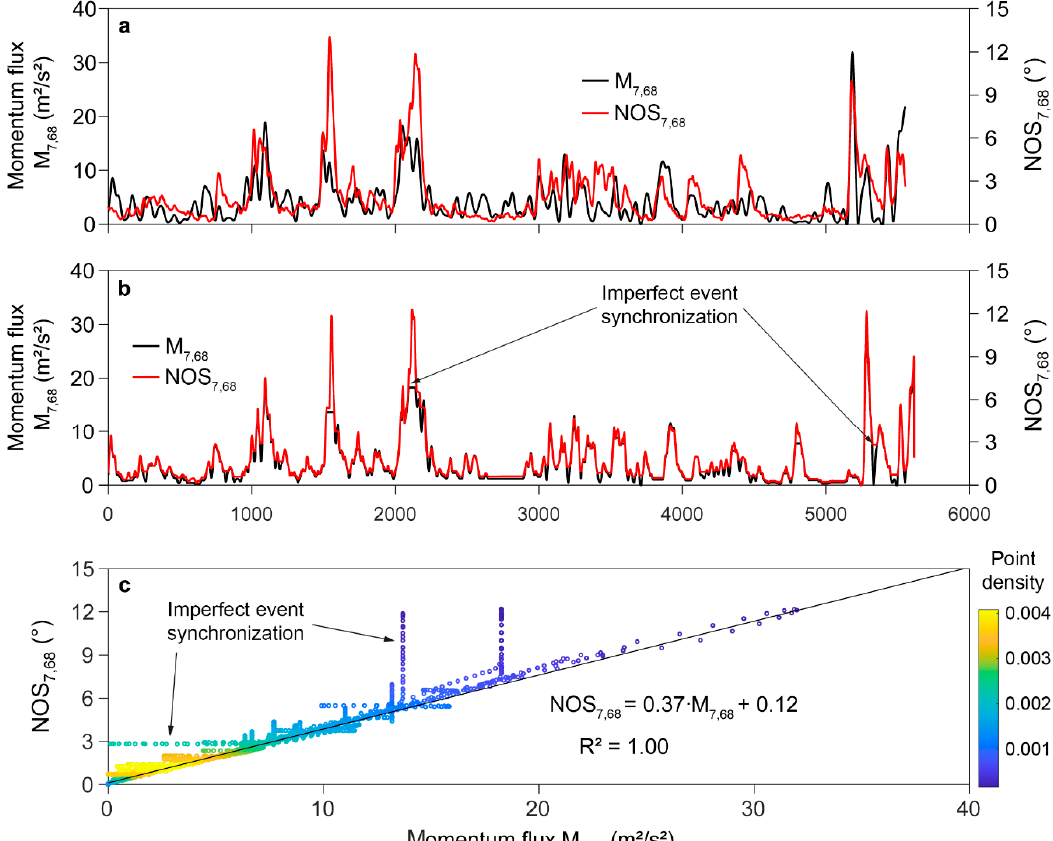
Figure 8. ( a ) Low-pass filtered momentum flux ( M 7,68 ) and non-oscillatory SSA component ( NOS 7,68 )